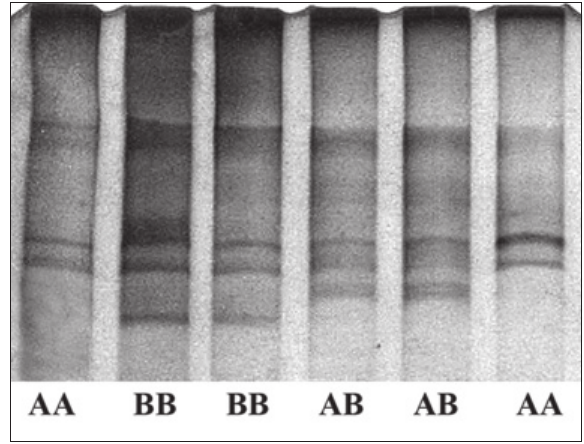
Figure-1: Polymerase chain reaction-single-strand conformation polymorphism patterns of Fragment I of heat shock protein 70